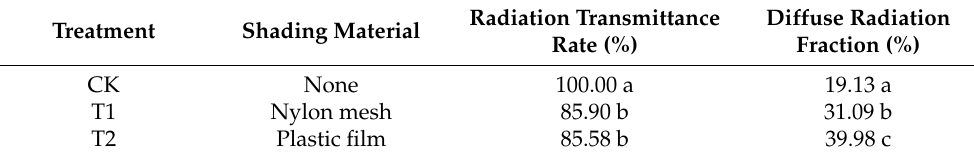
Table 1. Data of shading treatments.